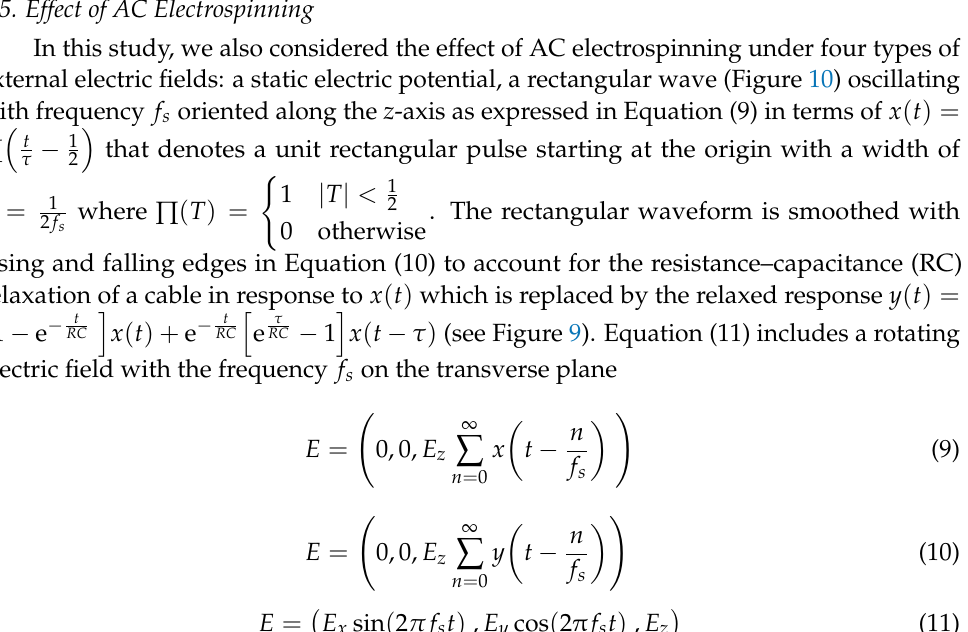
Figure 10. The rectangular waveform at f s = 0.5 × 10 3 Hz and its variant with the relaxation time constant RC = 0.2 ms used in simulations. Table 3. Baseline simulation parameters used in the electrospinning process.